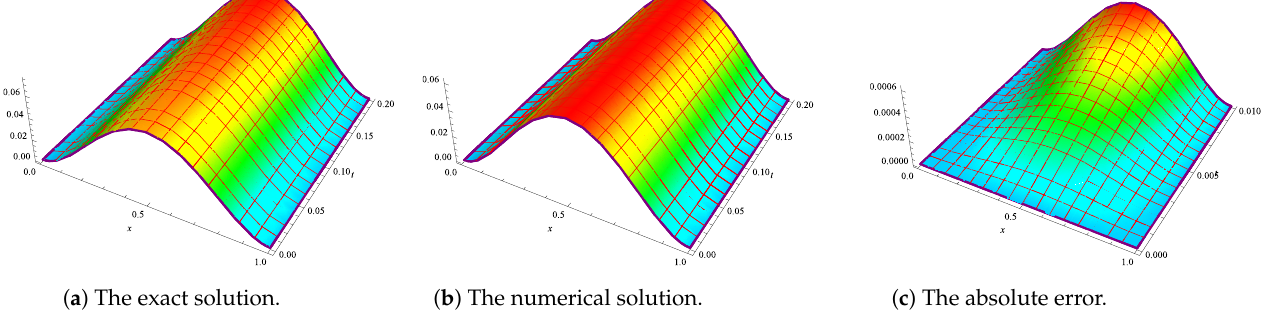
Figure 1. The numerical results at α = 1.3, ρ = 1, m = 2. The exact solution is ue ( x , t ) , the numerical solution is u 4 ( x , t ) , and the absolute error is | ue ( x , t ) − u 4 ( x , t ) | .